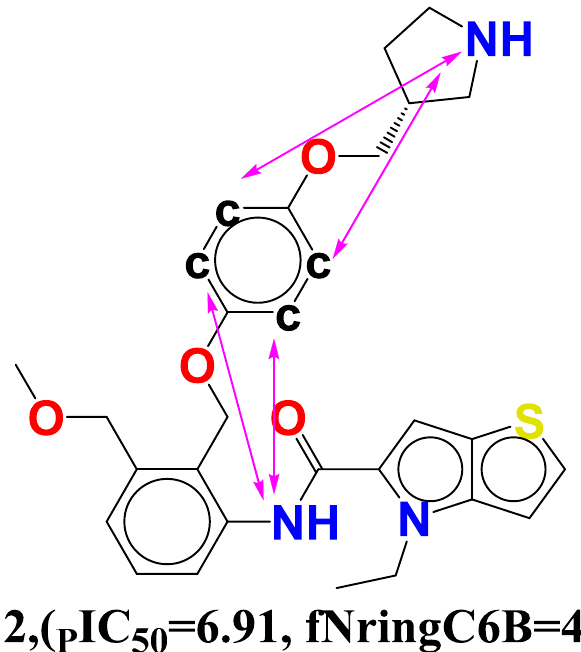
Molecules 2022 , 27 , x FOR PEER REVIEW 7 of 30